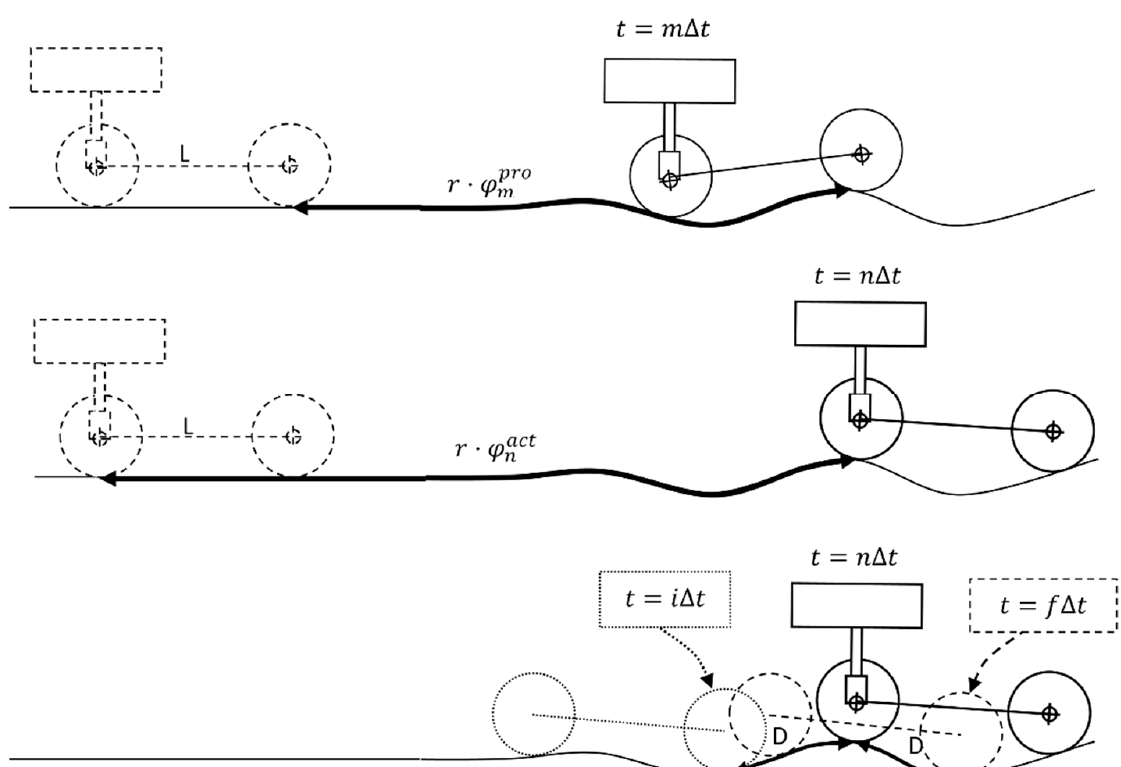
Figure 5. Sketch of the model at the key moments for the algorithm: at the initial position (dashed line in ( up ) and ( middle ) diagrams); when the record m is being registered ( up ); when the record n is being registered ( middle ); when the record i is being registered (dotted line, ( down )); when the record f is being registered (dash line, ( down )).